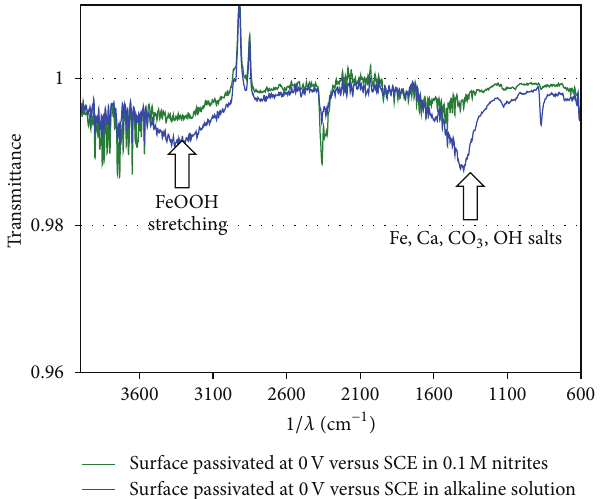
Figure 12: FTIR spectra of specimens passivated in solution at pH 13.5 and 0 V versus SCE without and with 0.1 M NaNO 2 .